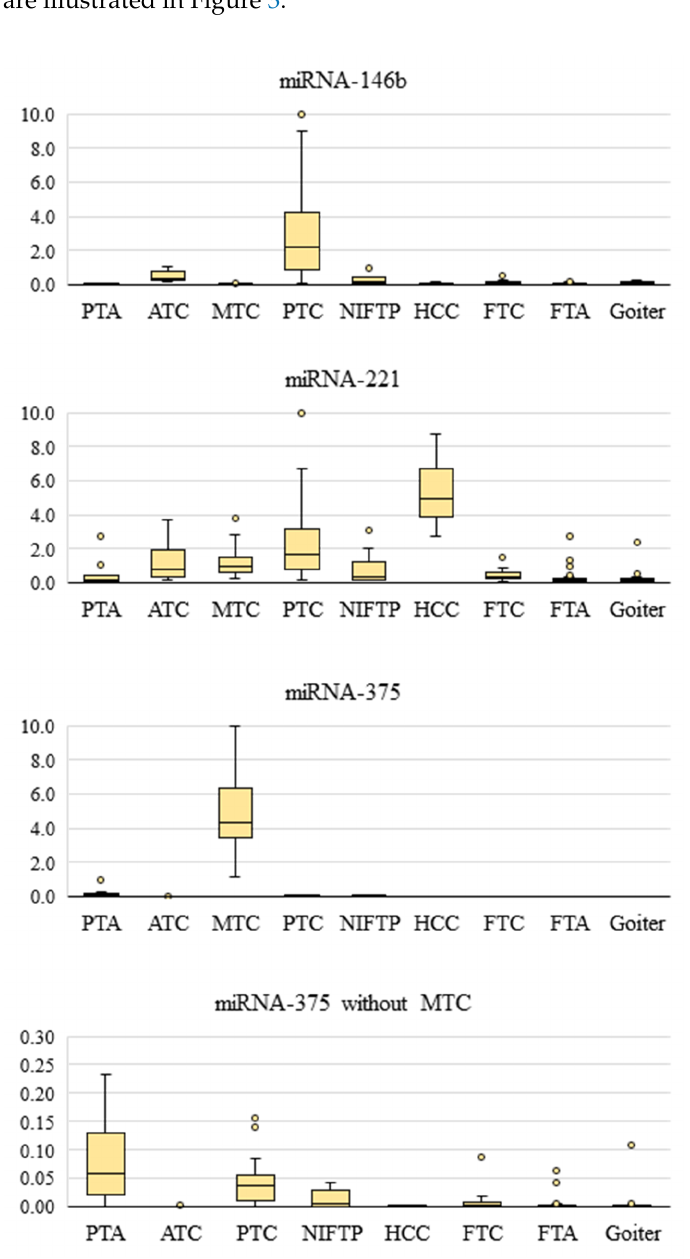
Figure 3. Relative expression levels of three miRNAs in goiters and thyroid/parathyroid tumors. The data are normalized; the figure shows the median value, upper and lower quartiles, a nonoutlier range, and outliers (circles).